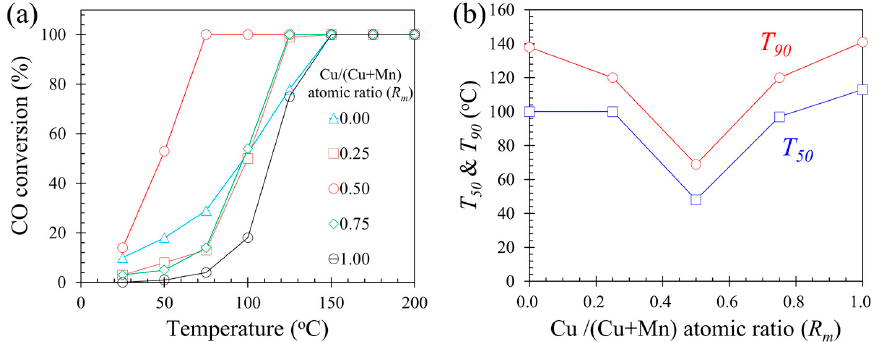
Figure 1. ( a ) CO conversion on each catalyst as a function of reaction temperature. ( b ) T 50 and T 90 as a function of Cu/(Cu + Mn) atomic ratio ( R m ).